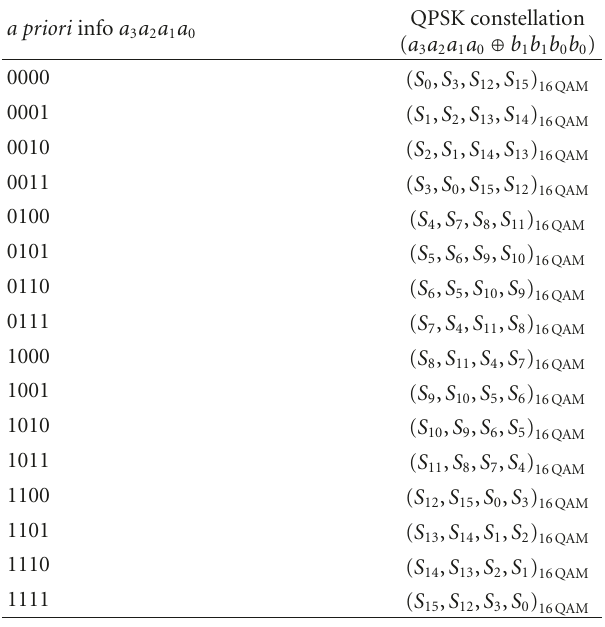
Table 1: Constellation conversion from 16QAM to QPSK ( a 3 a 2 a 1 a 0 represents the a priori info, b 1 b 0 are the info bits to be received).